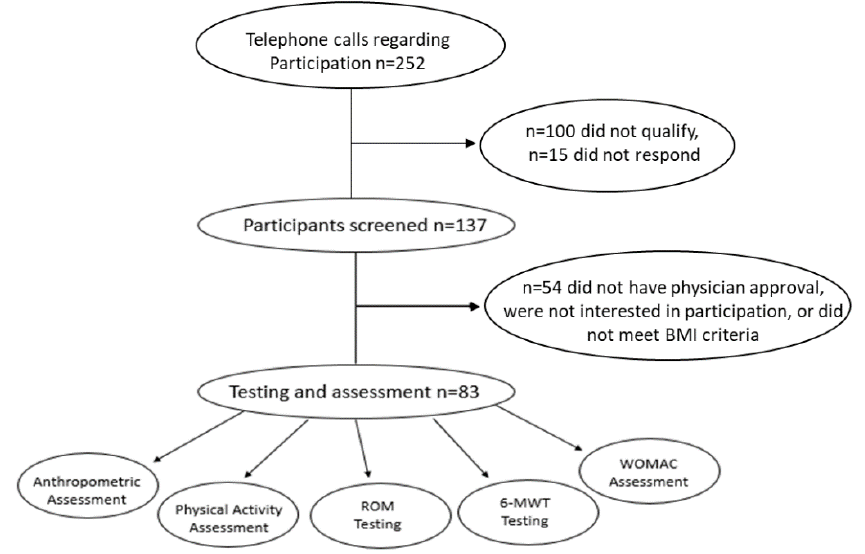
Figure 1. Study Figure 1. Study flowchart.